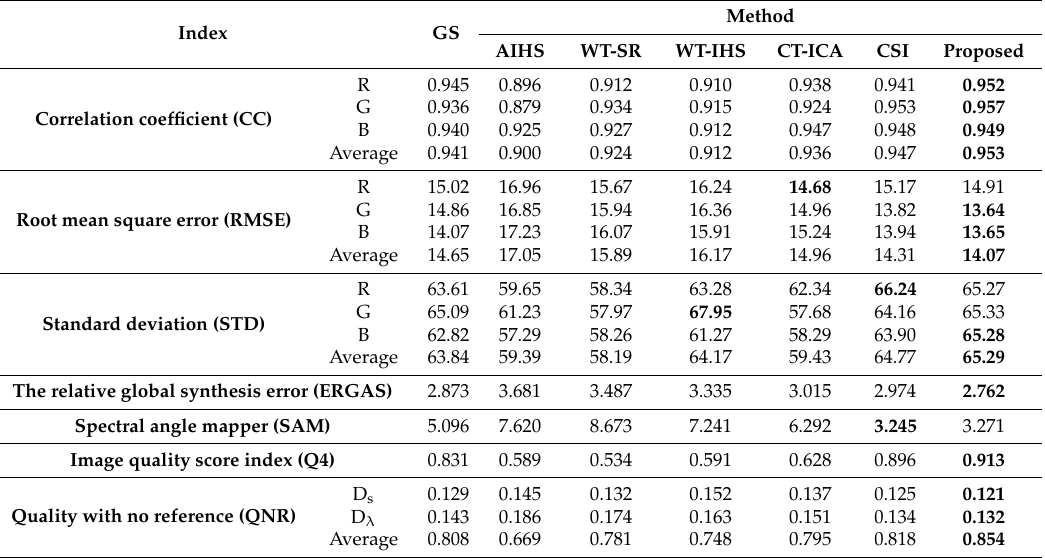
Table 2. Evaluation indices of fusion results for WorldView-2 data.